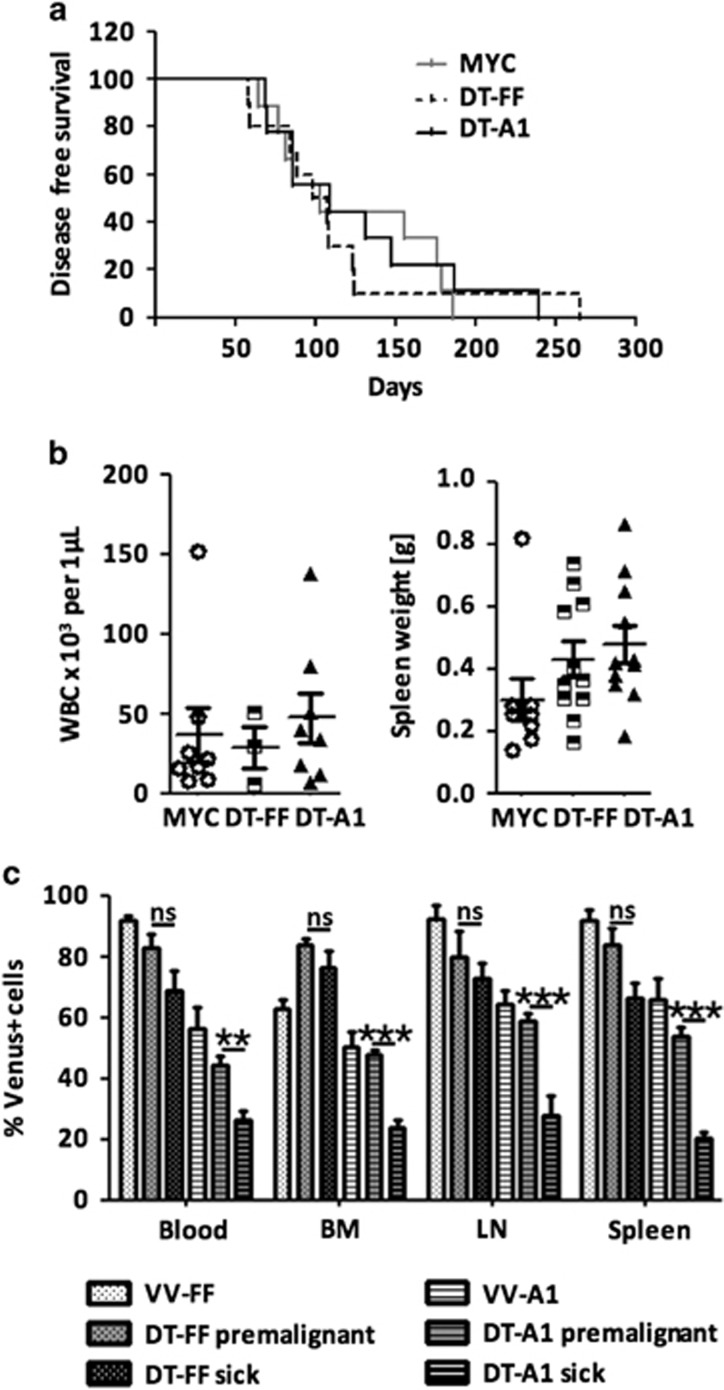
A1 knockdown cells are counter-selected in Eμ-MYC-driven lymphomas. (a) Kaplan–Meier analysis of disease-free survival of mice of the indicated genotypes (MYC n=8, DT-FF n=10, DT-A1 n=11). MYC vs DT-A1 P=0.6093; DT-FF vs DTA1 P=0.6345 (Mantel–Cox); median survival: MYC 103 days, DT-FF 102.5 days, DT-A1 109 days. (b) Left panel: white blood cell counts in the blood of moribund mice. Dots represent individual blood count in diseased mice and bars represent the corresponding means (MYC n=8, DT-FF n=3, DT-A1 n=8 mice). Right panel: Spleen weights of diseased mice of the indicated genotypes (MYC n=7, DT-FF n=10, DT-A1 n=11 mice). No significant differences were noted. (c) Quantification of the fraction of Venus+ cells in primary and secondary lymphatic organs derived from premalignant and diseased DT-FF and DT-A1 mice (VV-FF n=3, VV-A1 n=5, DT-FF premalignant n=5, sick n=5; DT-A1 premalignant n=11, sick n=6; biological replicates, six independent experiments). Bars represent means±s.e.m. ANOVA followed by Bonferroni post hoc test. **P⩽0.01, ***P⩽0.001.